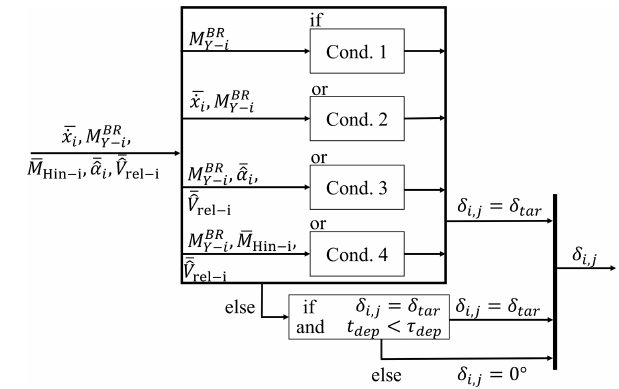
Figure 8. Graphical representation of the controller logic. The con- ditions 1 to 4 are given by Eqs. (31) to